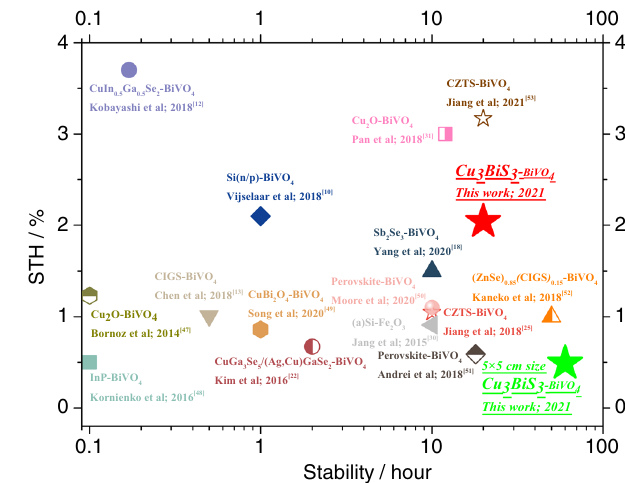
Fig. 5 Benchmarks for previously reported photocathode-photoanode tandem cells. Ef fi ciency and stability benchmarks of the previously reported photocathode-photoanode tandem cells for standalone water splitting. The statistical PEC performance parameters are shown in Table